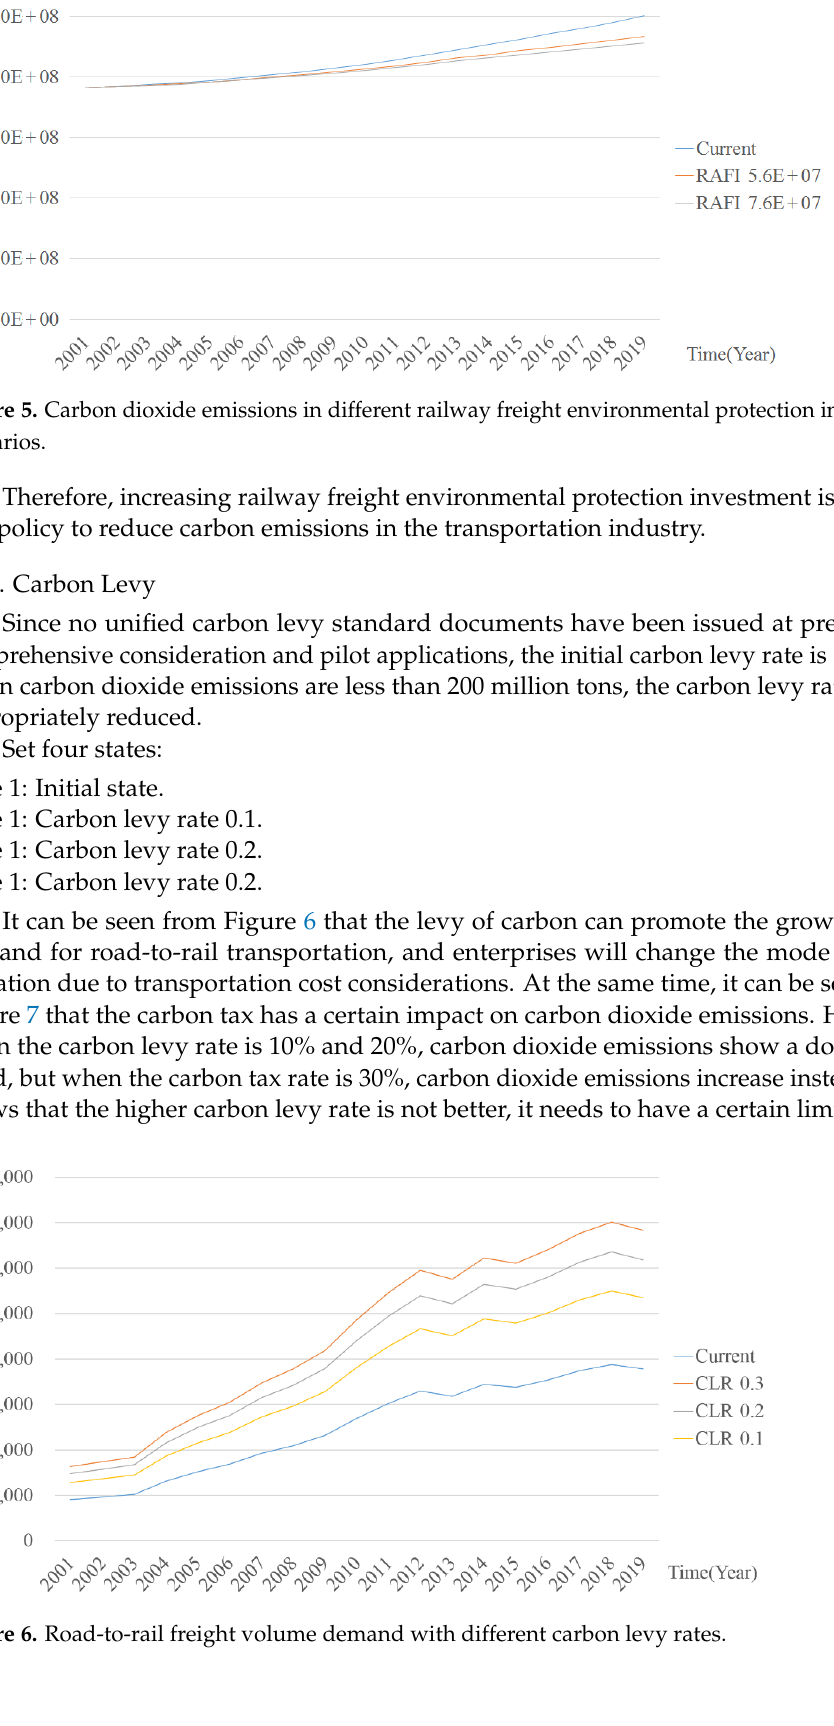
Figure 7. Carbon dioxide emissions with different carbon levy rates. 5. Discussion From our paper’s analysis, it can be seen that current policies, such as increasing in- vestment in environmental pollution treatment by industry, have a good effect on reduc- ing carbon emissions in the transportation industry. However, it is also necessary to un- derstand that to further implement investment and increase governance efforts, not only should analysis of investment theory be used, it also needs to be improved in combination with practice. In addition, the formulation of transportation carbon tax is still in the theoretical stage in most regions, and no specific policy formulation or implementation has been car- ried out. From the simulation experiment in our research, we can also see that there are certain difficulties in determining the carbon levy rate, and it can be concluded that a higher carbon levy rate may not be better. Using the simulation and calculation methods proposed in our paper, the final reasonable range of the carbon tax rate should be between 10 and 20%. Exceeding this range will cause the transfer of short-distance transportation on roads to railway transportation. This situation will increase the carbon emissions of railway transportation and increase the carbon emissions of the entire system. Therefore, follow-up carbon tax research is still worthy of further discussion.